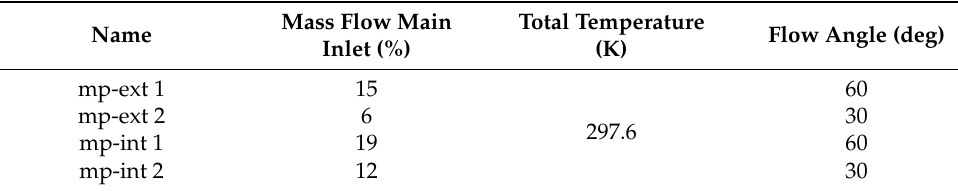
Figure 2. Computational domain for a combustor simulator ( a ) and a combustor simulator with NGV ( b ). Table 2. Boundary conditions at multiperforated